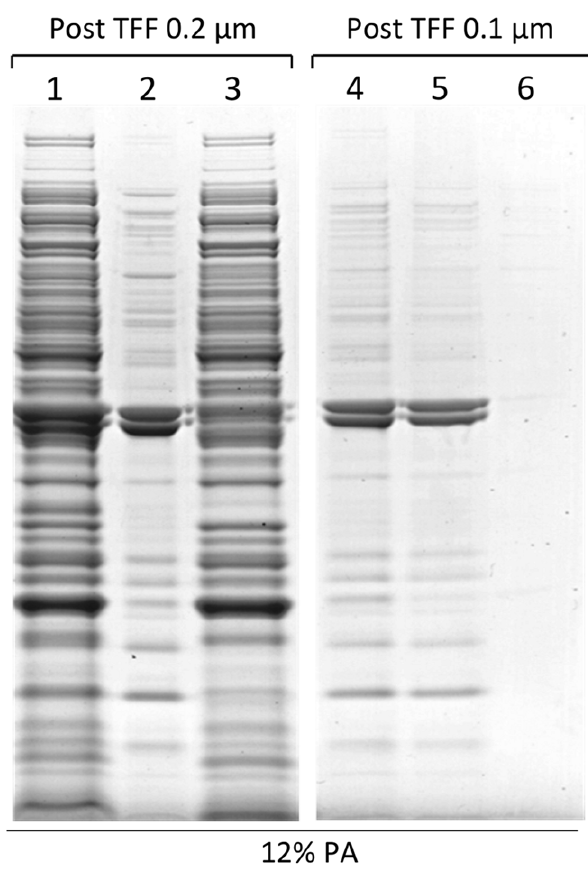
Figure 2. GMMA enrichment and purity after TFF. GMMA were purified from a 5 L fermentation culture of S. sonnei D tolR D galU grown in HTMC at 37 u C to OD 45 using 2-step TFF. In the first step, the culture supernatant which contains the GMMA was separated from the bacteria using a 0.2 m m filter. The biomass was subjected to 5 diafiltration steps and all filtrates were combined with the initial supernatant to obtain the total permeate. To determine the amount of GMMA in the permeate, GMMA were separated from soluble proteins by ultracentri- fugation. After ultracentrifugation, the pellet (GMMA) was resuspended in the initial volume of the centrifuged material to normalize all samples to fermentation volume. Equivalent volumes of the 0.2 m m filtrate before ultracentrifugation (1), the resuspended GMMA pellet (2), and the supernatant of the ultracentrifugation (3) were separated by SDS- PAGE (12% PA) and showed a large amount of soluble proteins (3) in comparison to GMMA-associated proteins (2) to be present in the post 0.2 m m TFF permeate. In the second TFF step, GMMA were separated from soluble proteins using a 0.1 m m filter. The retentate (4) was analyzed by ultracentrifugation as described above and was found to contain almost exclusively GMMA (5) as determined by the strong reduction of soluble proteins